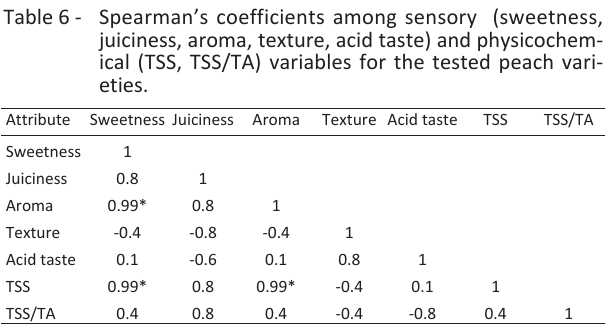
Significant coefficients are denoted by an asterisk at P